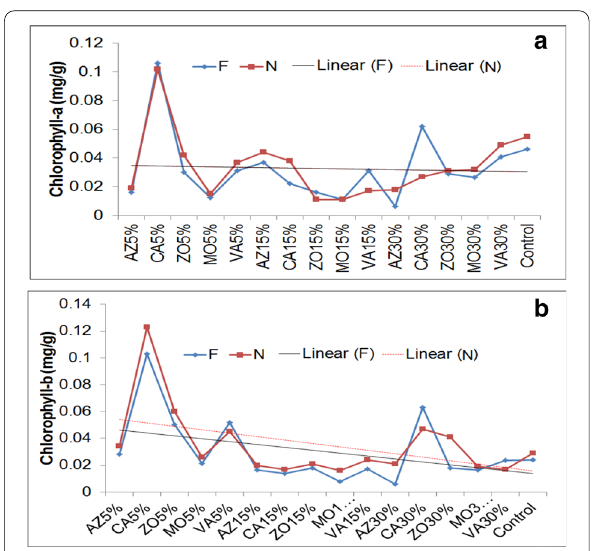
Fig. 3 Chlorophyll in leaves of in rice plants exposed to the experimental conditions. Keys: N plant innon-ferruginous soil, F